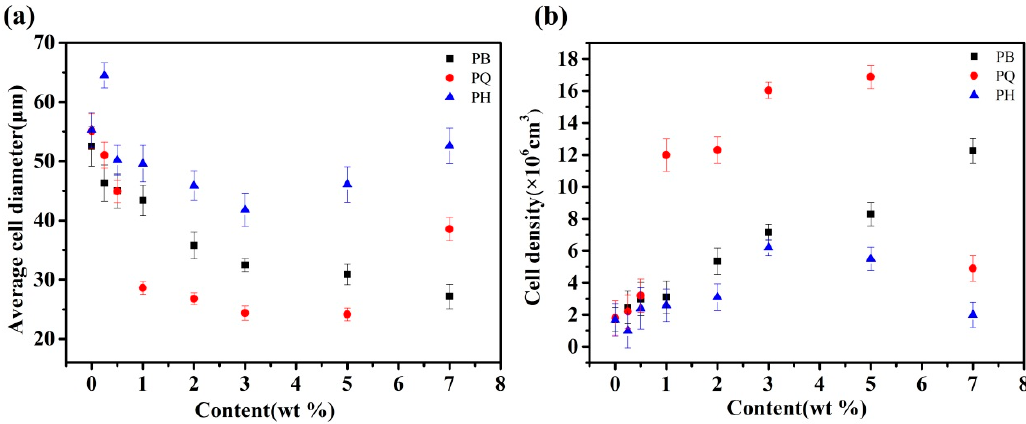
Figure 5. Average cell diameters ( a ) and cell densities ( b ) of the foamed PQ, PH, and PB.